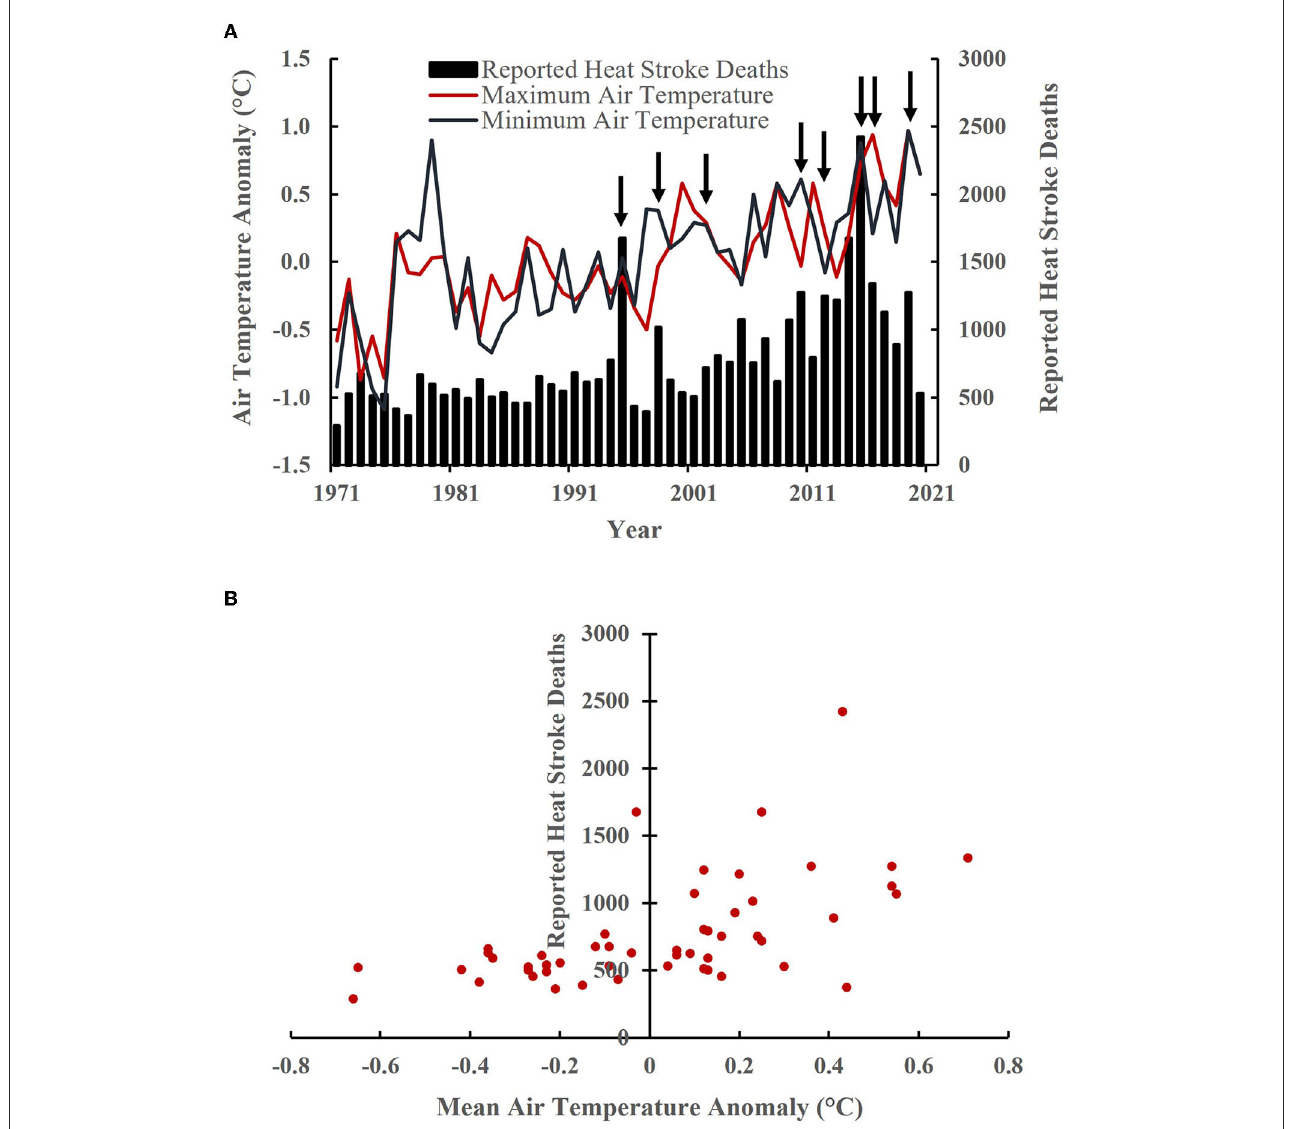
FIGURE6 (A) Annual minimum and maximum air temperature anomalies ( ◦ C; solid lines; primary y-axis) on Indian landmass (India Meteorological Department (IMD), 2021b) and reported (annual) number of heat stroke deaths (solid bars; secondary y-axis) in India in the last 50 years (1971–2020). Base period from 1981 to 2010 is used to compute the annual air temperature anomalies. National Crime Records Bureau (National Crime Records Bureau (NCRB), 2022) Accidental Deaths and Suicides in India (ADSI) individual reports from 1971 to 2020 were used to extract heat stroke deaths data. Black arrows mark